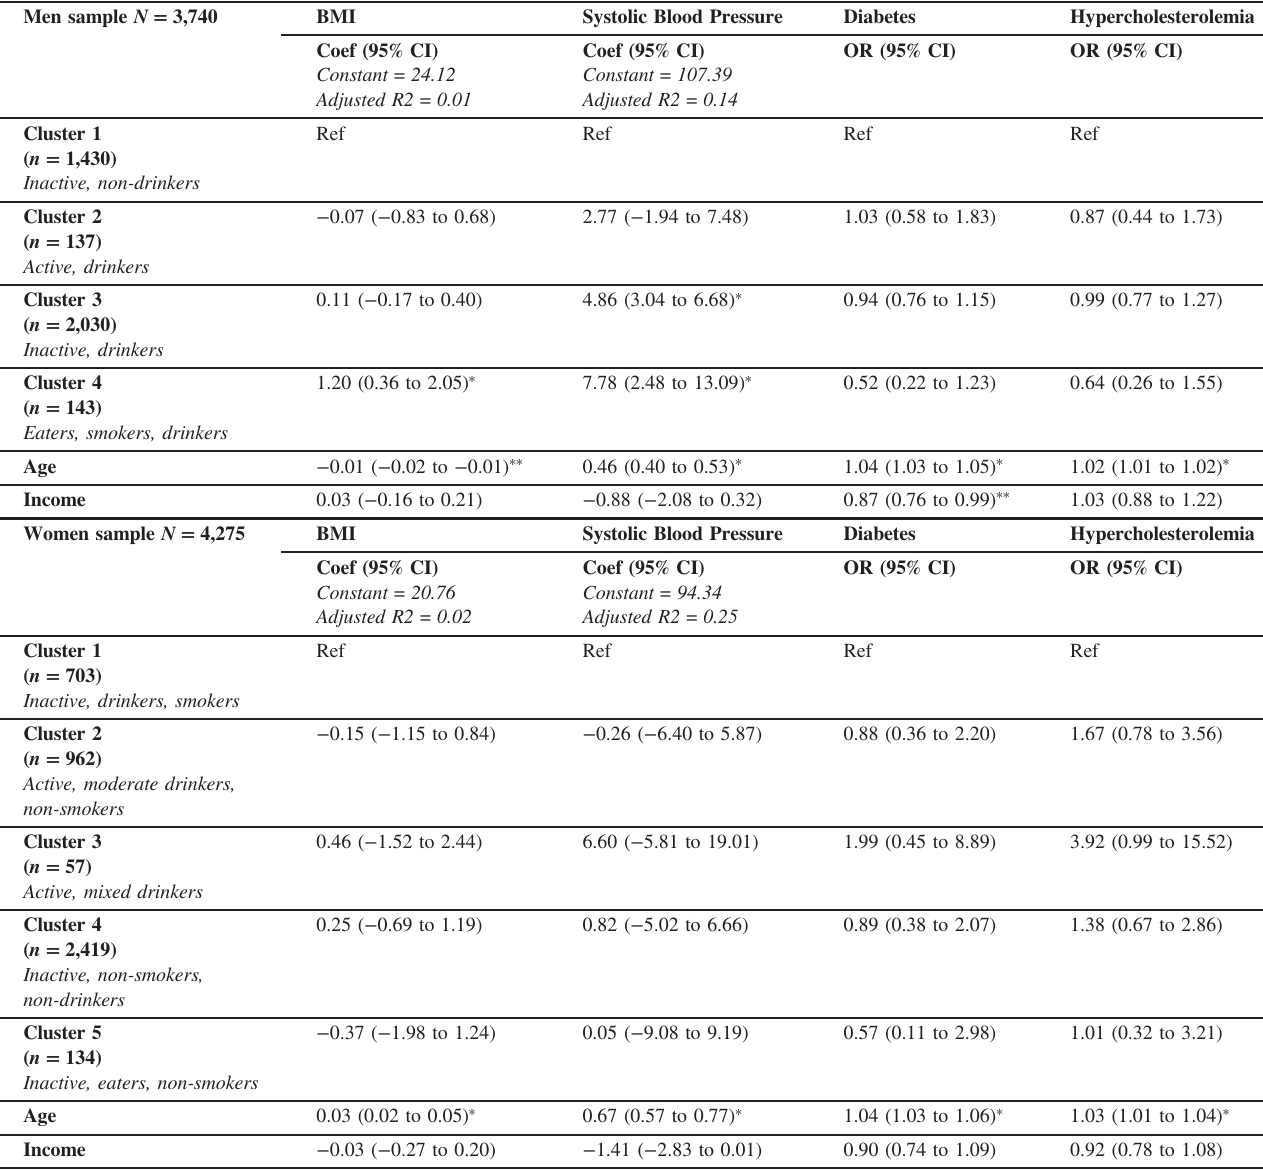
Table 4. Linear and logistic regression models estimating associations between cluster membership and health status, adjusting for age, income and classi fi cation